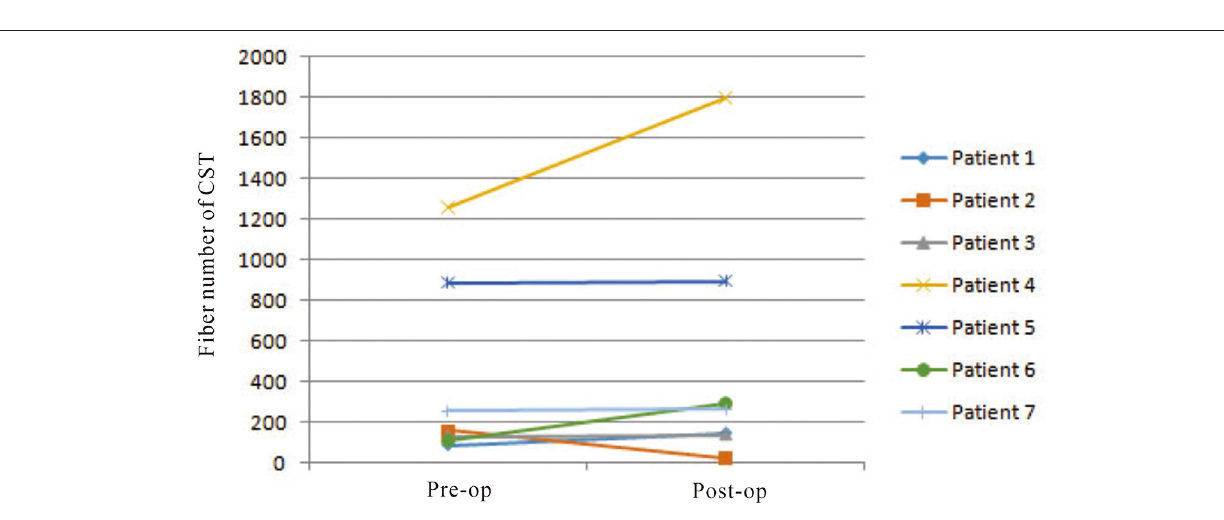
FIGURE 6 | The change of fiber numbers of ipsilateral CSTs on pre- and postoperative DTI images was not significant ( p =